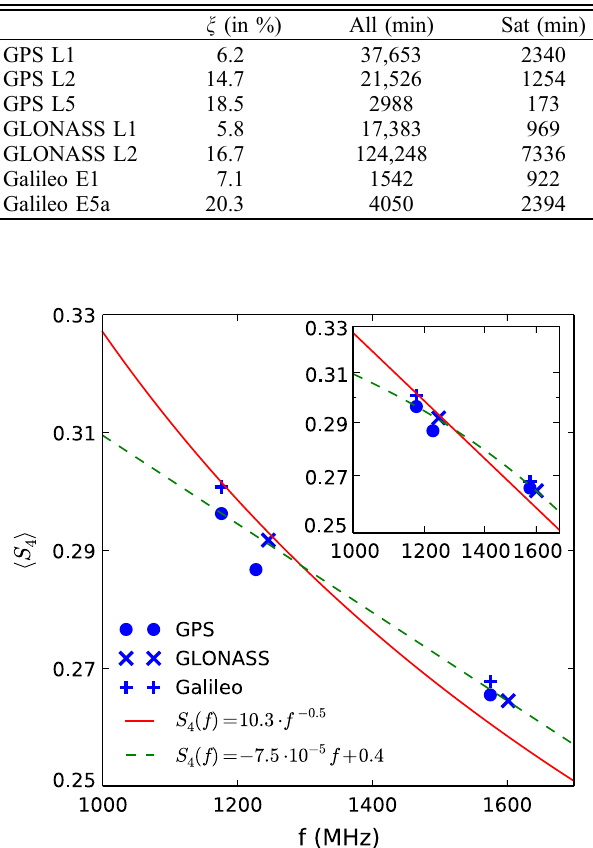
Figure 6. Mean of S 4 as function of frequency for the various signals. The solid lines are fits to the data. The inset shows the same results using double logarithmic